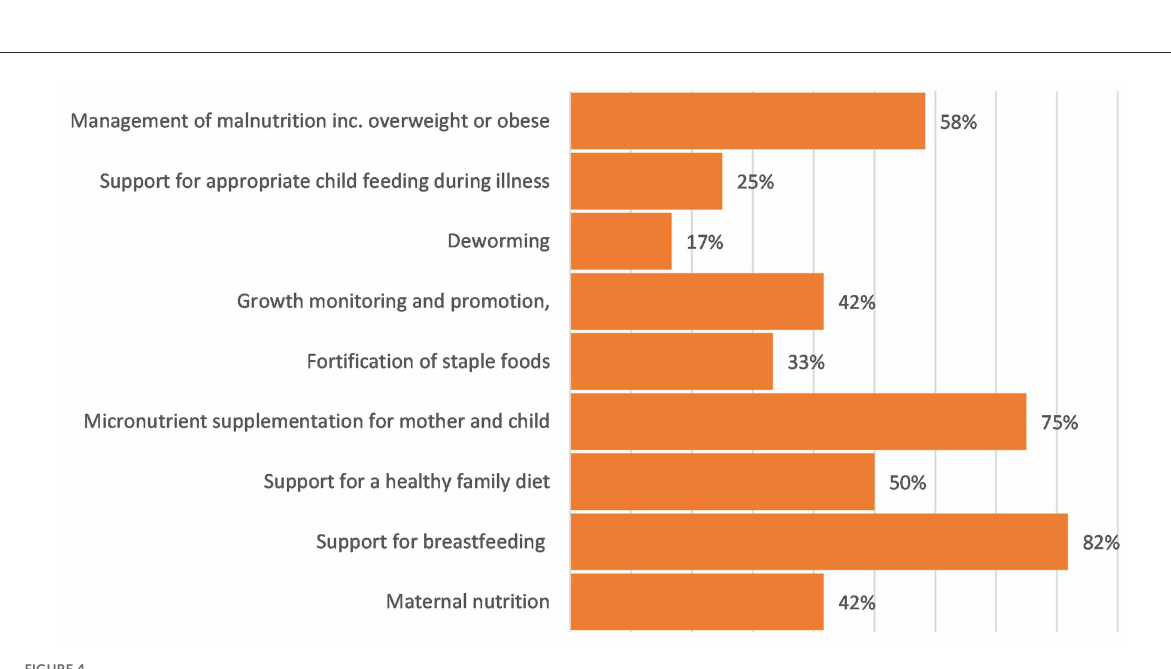
FIGURE3 Coverage of “Good Health” within county integrated development plans.